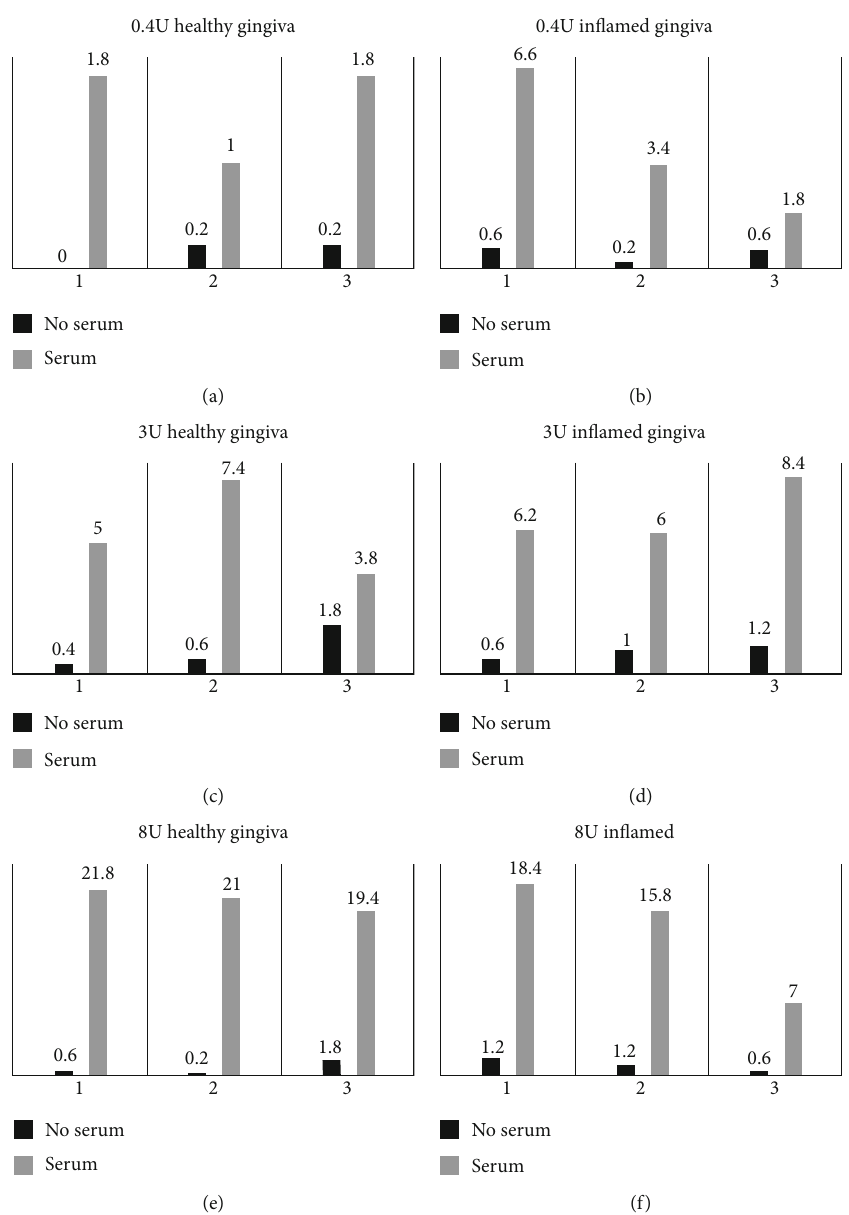
Figure 1: Mean counts of migrated GMSCs isolated from healthy and in fl amed gingival tissues through the di ff erent pore